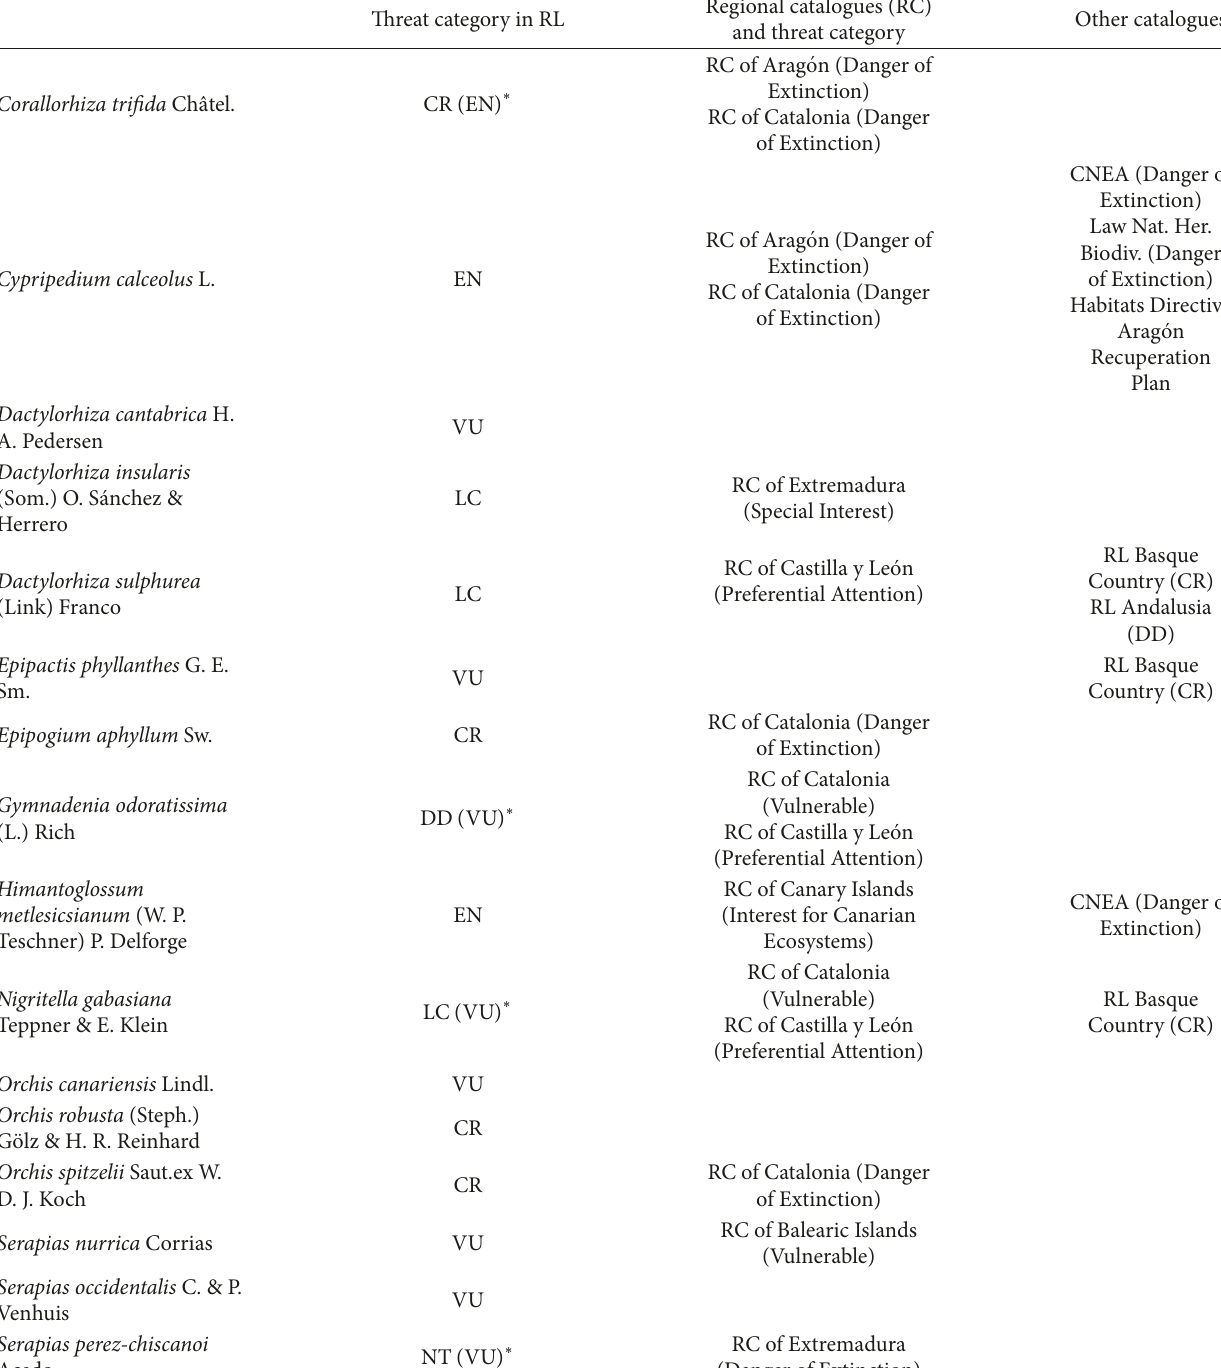
Table 1: The sixteen species included in 2010 Red List of Spanish Vascular Flora (RL) [86] following IUCN threat categories [120]. It is shown if they are included in any regional catalogue (RC) and the threat category within them, as well as if they are included in any other catalogue of protected